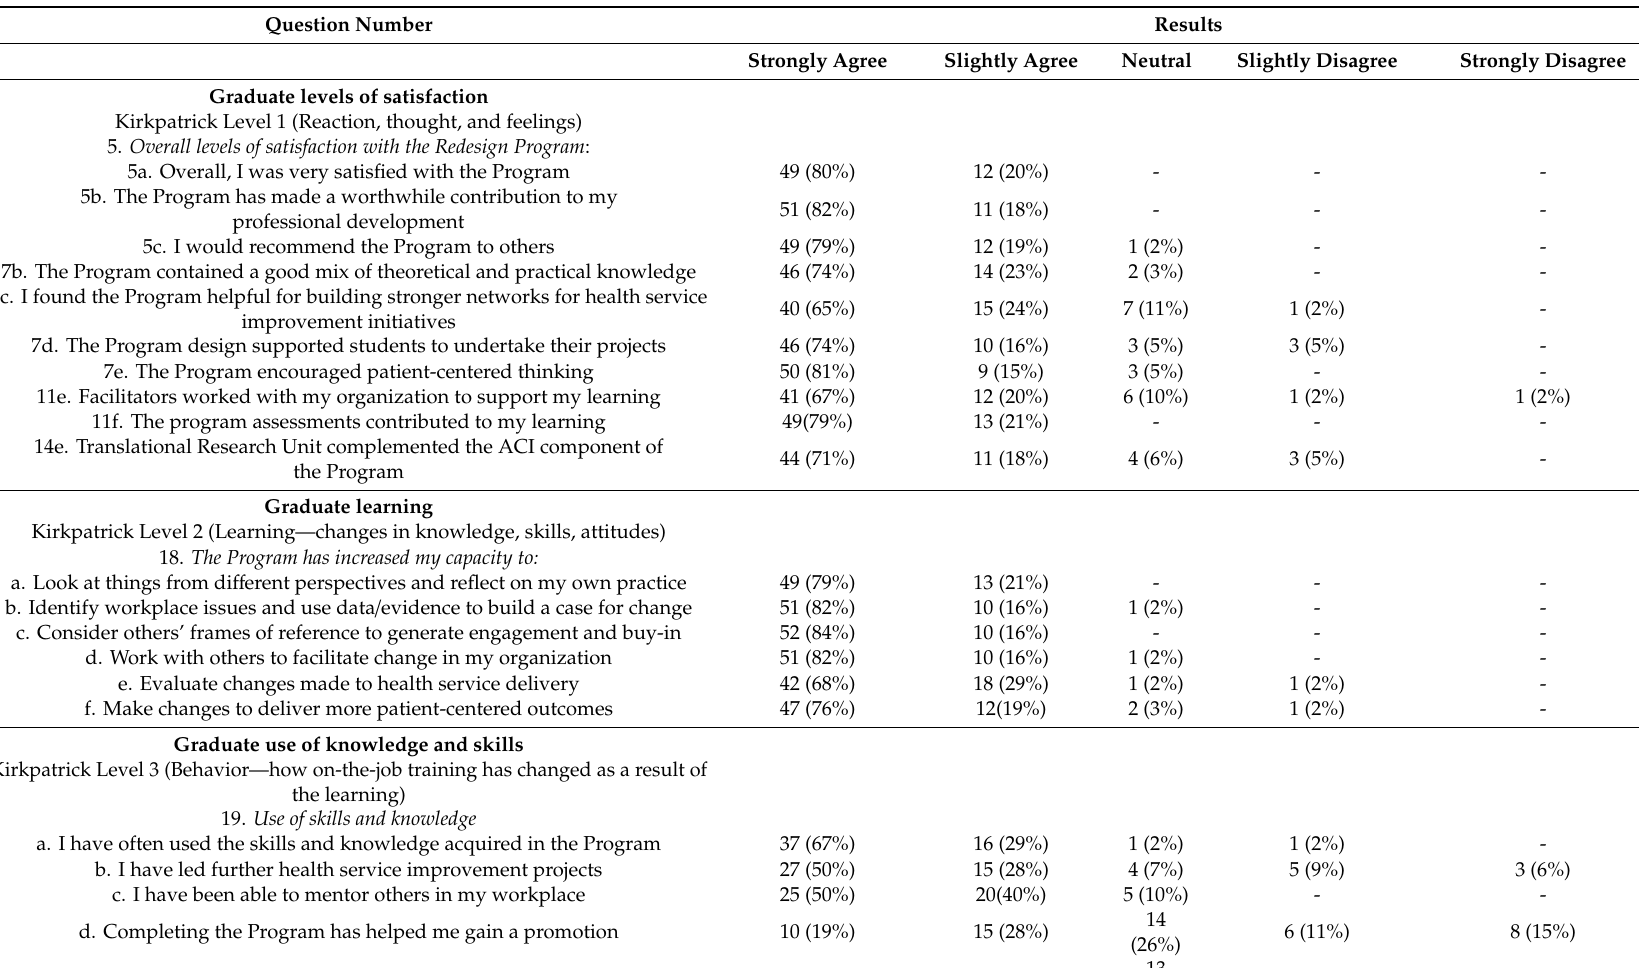
Table 3. Results of online